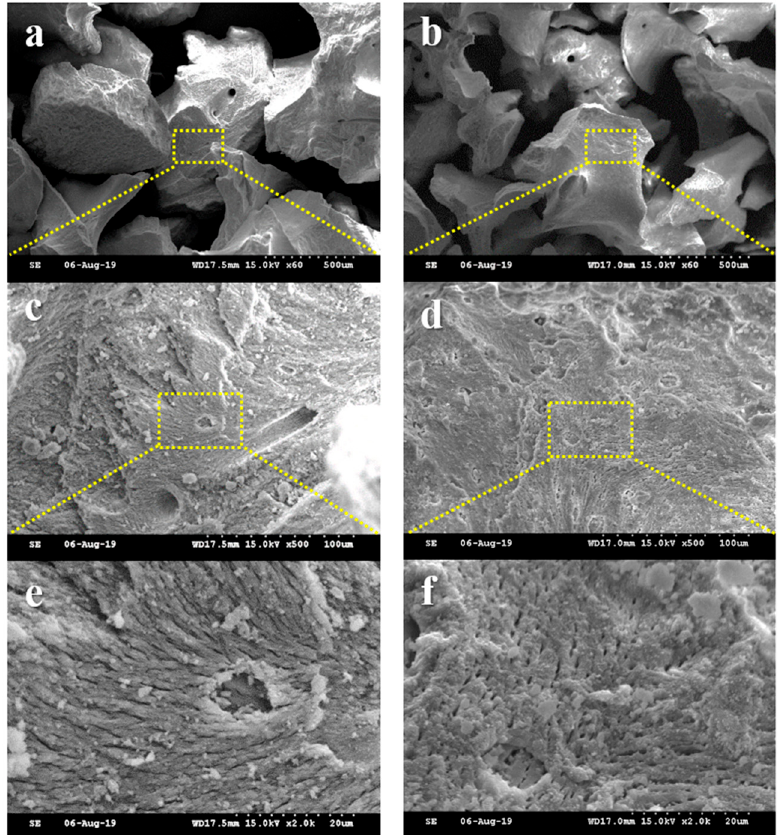
Figure 4. Comparative scanning electron microscope (SEM) images of each group. ( a,c,e ) Bio-Oss and ( b,d,f ) Bone-XP groups. [Original magnification: ×60 ( a,b ), ×500 ( c,d ), ×2000 ( e,f )].